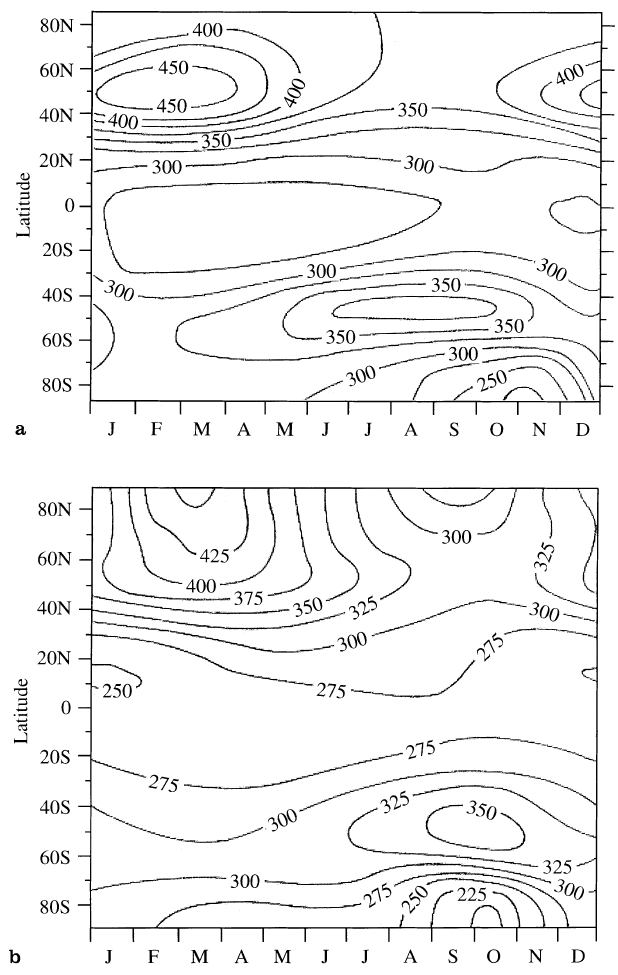
Fig. 1. a Variation of total ozone with latitude and season (in Dobson Units: DU); 11-year mean values of a simulation with ECHAM3/CHEM. b Variation of total ozone with latitude and season (in DU) for the time-interval 1984–1993, based on Global Ozone Observing System (GO OS) stations (reproduced from Bojkov 3 and Fioletov, 1995). The contour interval is